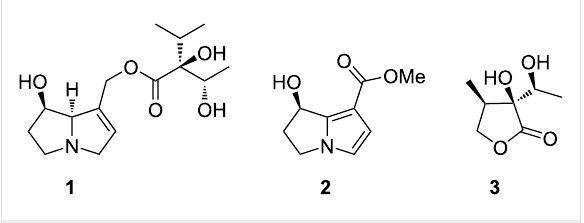
Scheme 1: Pyrrolizidine alkaloid lycopsamine ( 1 ) and the putative pheromone compounds methyl hydroxydanaidoate ( 2 ) and ithomiolide A ( 3